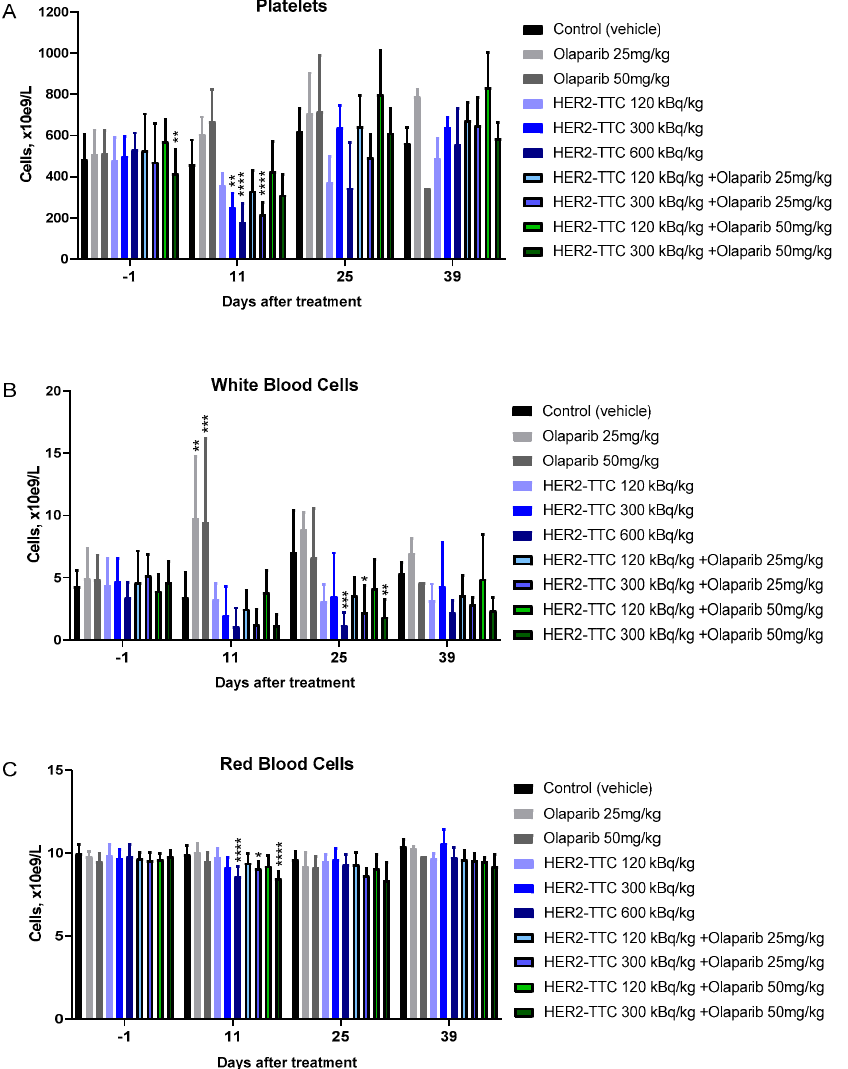
Figure 6. Hematology analysis in DLD-1 parental bearing mice. ( A ) Platelets, ( B ) white blood cells, and ( C ) red blood cells collected before dosing with HER2-TTC, olaparib, or combination therapy, and thereafter every other week. Analysis performed by using VetScanHM5.